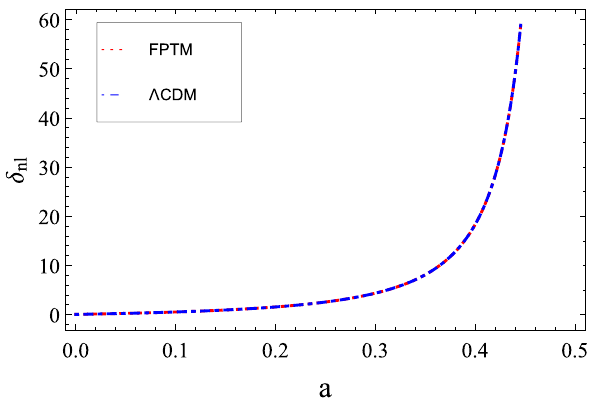
Fig. 12 The behaviour of the non-linear tachyonic perturbations δ l versus a for the Λ CDM and FPTM